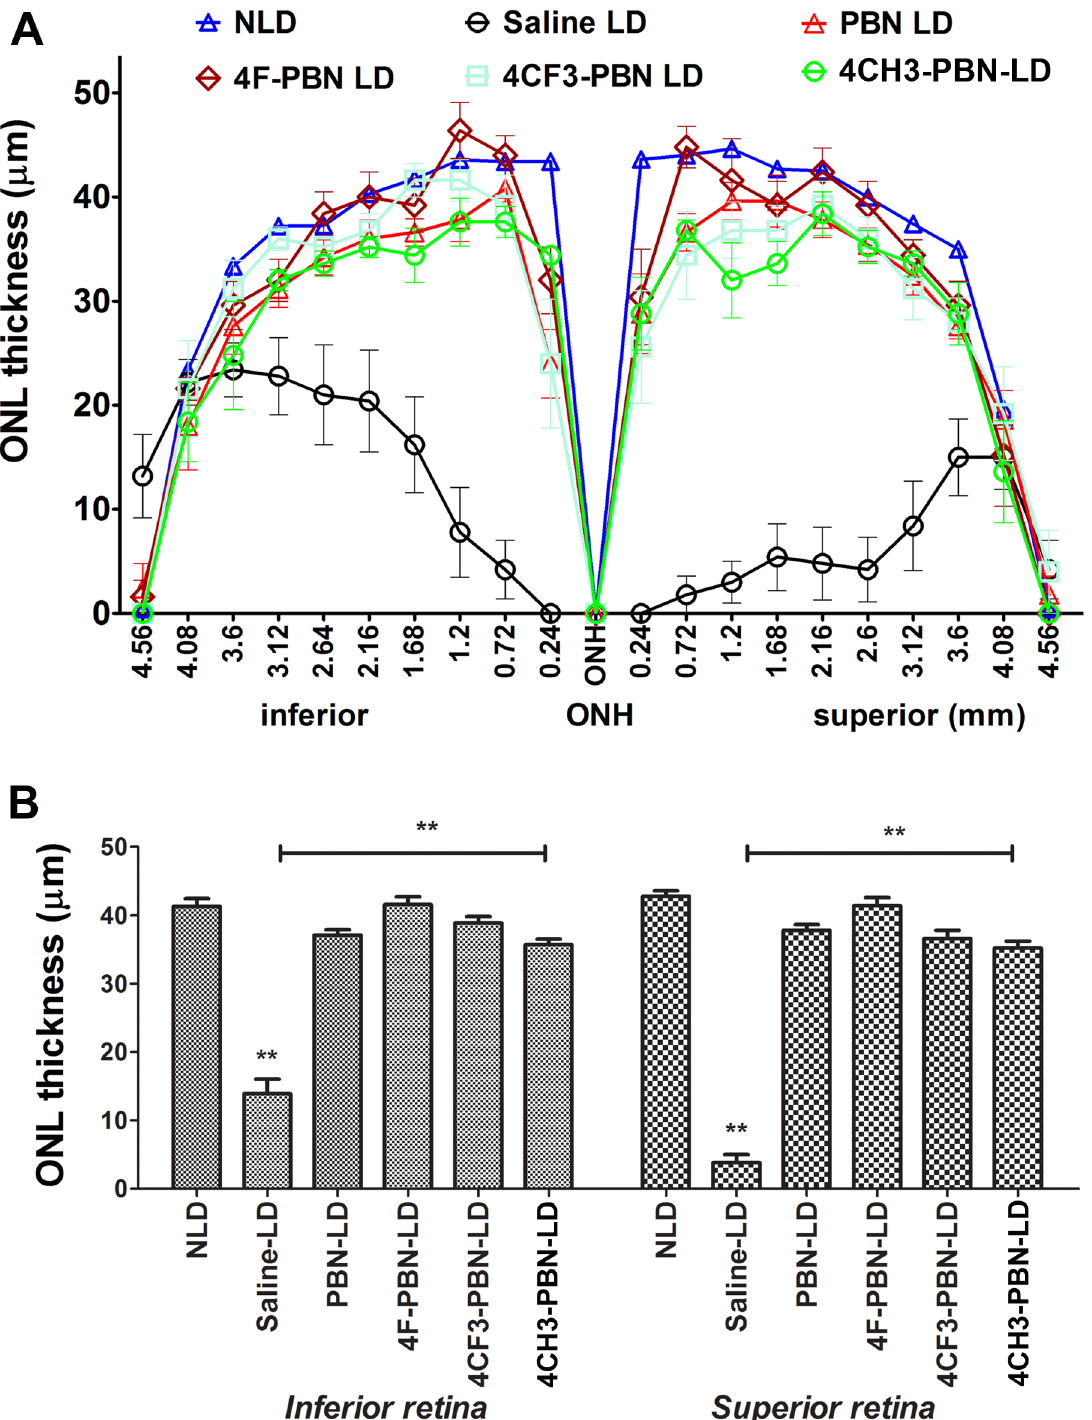
Fig 4. Histological analysis of rat retina confirms protection from light damage. Vehicle or Saline treated (Vehicle LD) rats lost most of their photoreceptors from the central retina. Effect is more pronounced in the superior retina. NLD is non-light-damage control. Fig 4A shows the ONL thickness across the retina in the vertical meridian. PBN treatment (PBN LD) retinas retained ~90% of photoreceptor cells. 4-CF 3 -PBN is comparable to PBN in protection, whereas 4-F-PBN appears better than PBN. 4-CH 3 -PBN also protects the retina significantly, although its effect is slightly less than PBN. Fig 4B shows central retinal outer retinal layer (ONL) thickness in both inferior and superior retina. [ ** = p < 0.001; n = 8 –